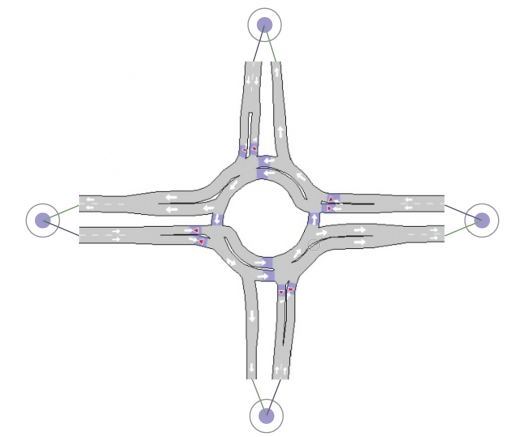
Figure 3: The turbo roundabout model in simulation